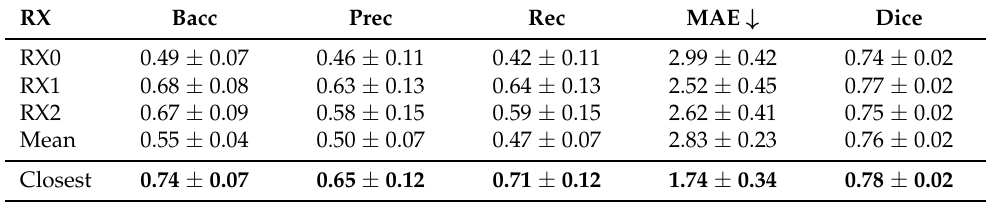
Table 1. Nodule growth prediction performances obtained by the U-HPNet using estimated means. The down arrow means the lower the score the better, and the best results are in